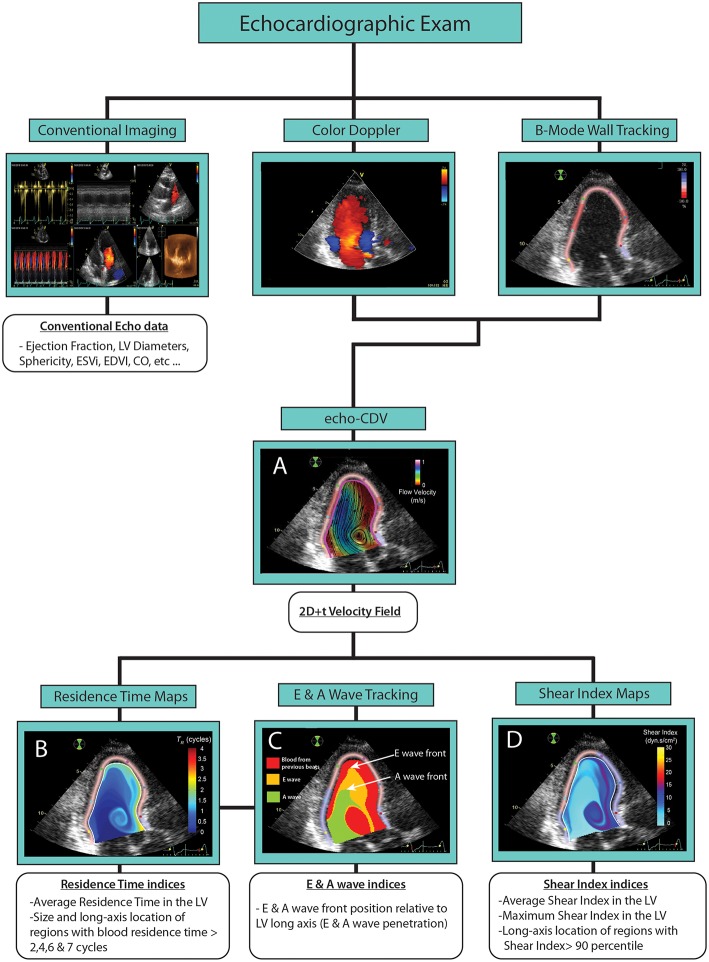
Methods of image acquisition and processing. (A) Echo CDV velocity maps. (B) Residence Time maps. (C) E & A waves tracking maps. (D) Shear index maps.